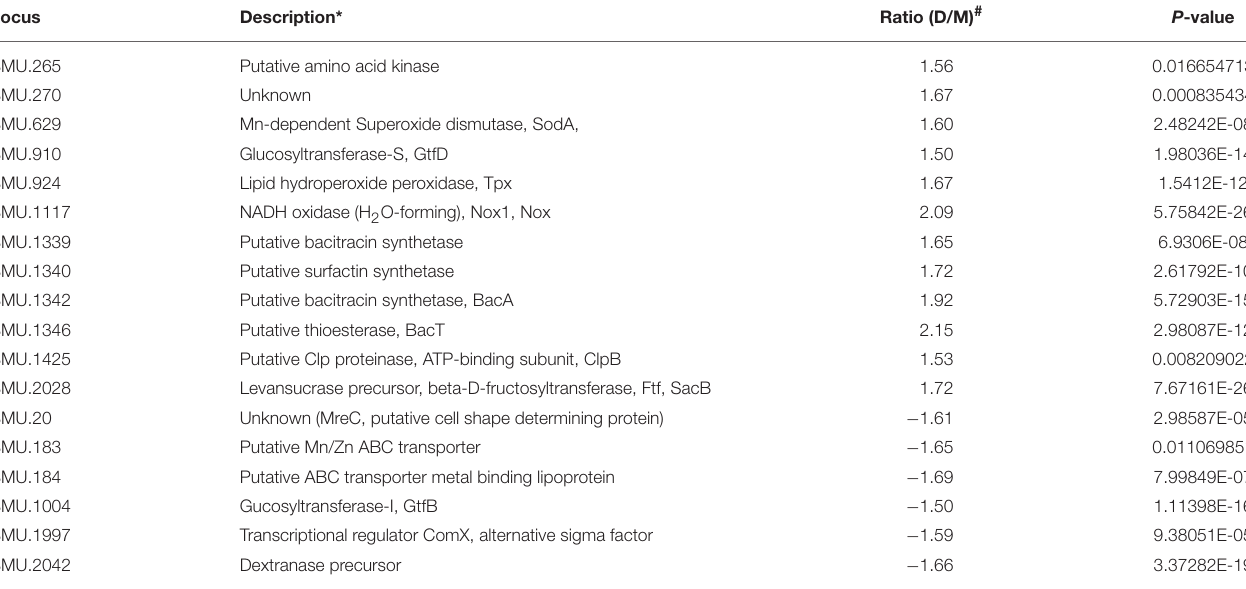
TABLE 2 | Selected genes identified by RNA-Seq analysis. Locus